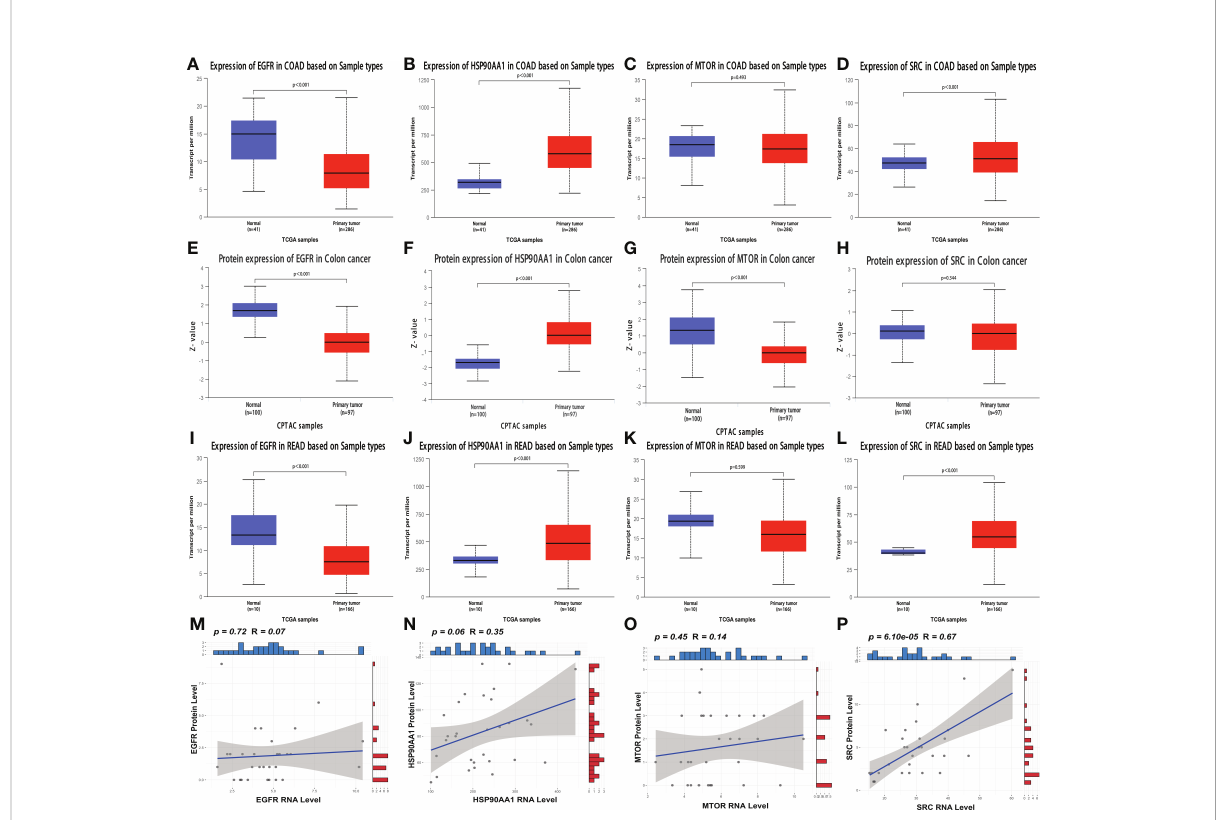
FIGURE 6 Analysis of the expression and correlation of key genes at the protein and transcript levels (A – D) The transcriptional expression of EGFR (A) , HSP90AA1 (B) , MTOR (C) and SRC (D) in normal and CC tissues. (E – H) The protein level of EGFR (E) , HSP90AA1 (F) , MTOR (G) and SRC (H) in normal and CC tissues. (I – L) The transcriptional expression of EGFR (I) , HSP90AA1 (J) , MTOR (K) and SRC (L) in normal and RC tissues. (M – P) The correlation analyses between RNA expression and protein level of EGFR (M) , HSP90AA1 (N) , MTOR (O) and SRC (P) in RC